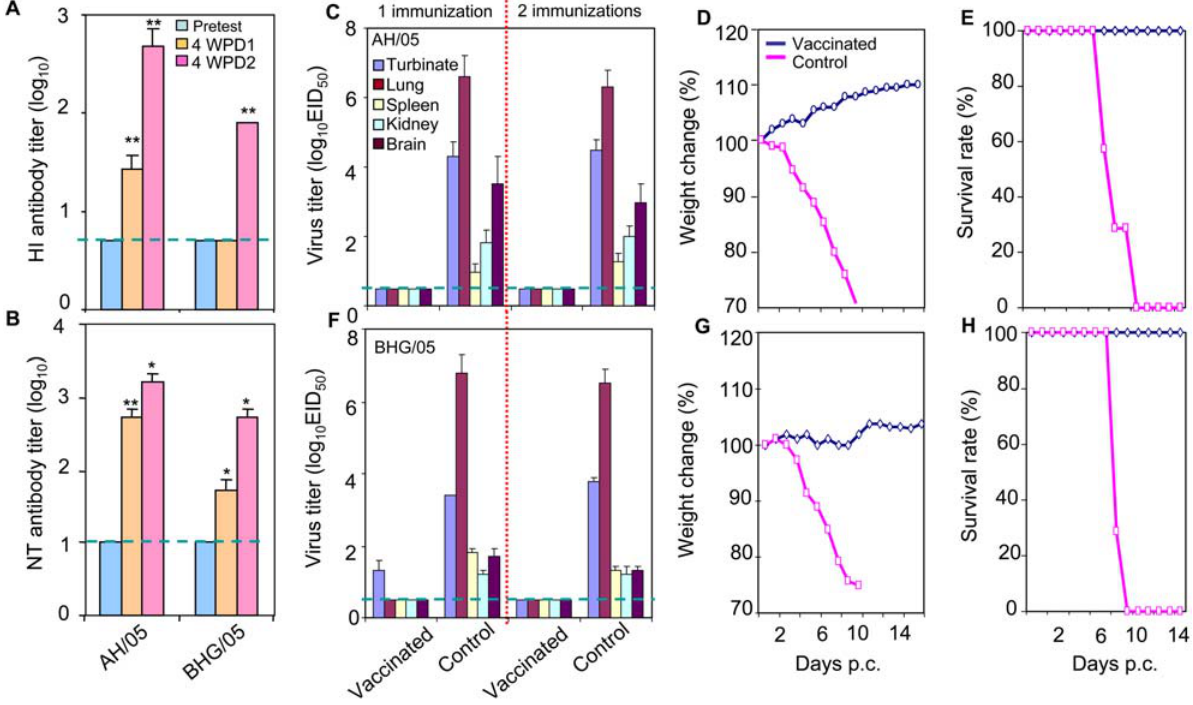
Figure 1. Vaccine efficacy of the AH/AA ca virus in mice. (A) HI and (B) NT antibody responses to homologous (AH/05) and heterologous (BHG/ 05) viruses after intranasal vaccination with 10 6 EID 50 of AH/AA ca in a 50- m l volume. Serum samples were collected on day 0 prevaccination (blue), 4 weeks after the first (orange) and 4 weeks after the second vaccination (pink). Asterisks indicate a statistically significant difference from antibody titers measured at the preceding time point: **, P , 0.01, *, P , 0.05. (C–H) Protective efficacy against challenge with the AH/05 (C–E) or BHG/05 virus (F–H). Weight changes (D and G) and survival rates (E and H) are shown only for the groups that were immunized once. The data in panels A–C and F are reported as means 6 s.d.; the dashed blue lines in these panels indicate the lower limit of detection. p.c.,